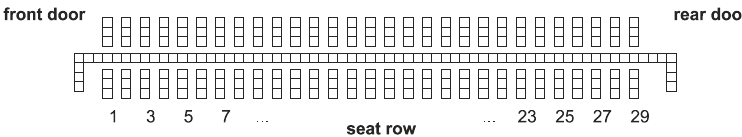
Figure 1. Grid-based simulation environment—Airbus A320 as reference.